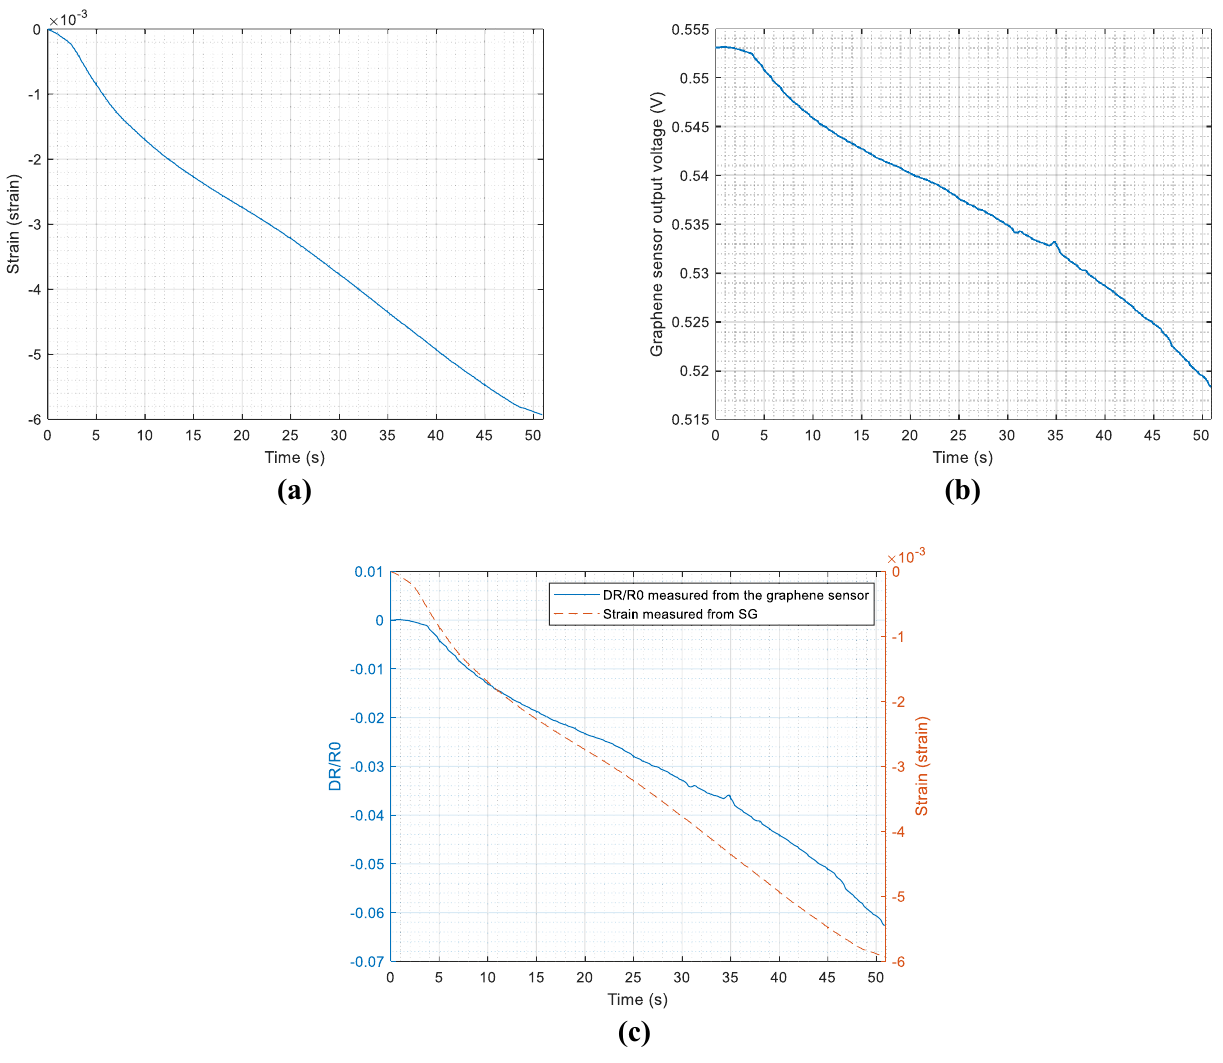
the graphene-based strain sensor to strain measurement obtained from strain gauge under normal compression